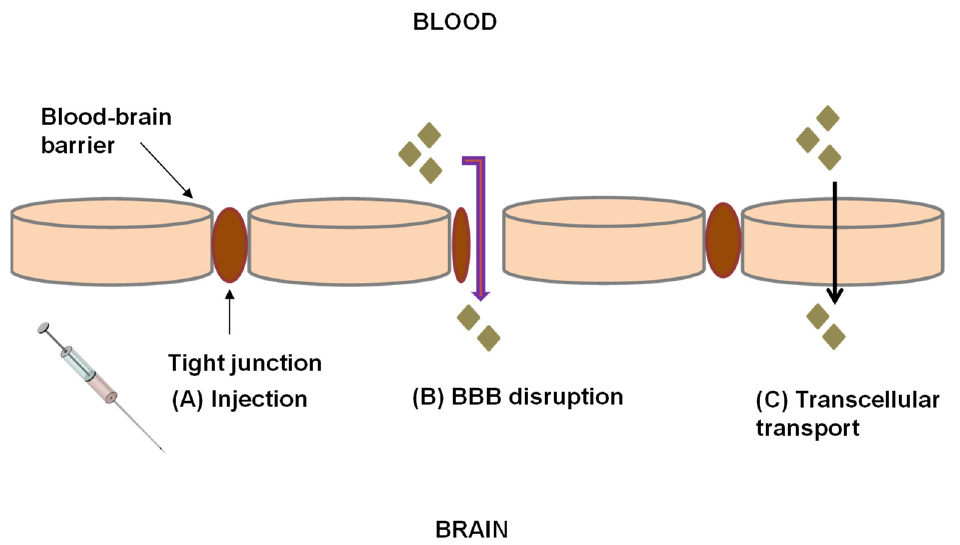
Figure 1. Strategies for crossing the BBB to deliver drugs. ( A ) Invasive approach: injection into the parenchyma of the brain is used to avoid the BBB when treating patients. ( B ) BBB disruption is achieved by injection of chemical agents, osmolytes or via focused ultrasound. This technique causes loosening of the tight junctions of the endothelium, permitting access to the brain by conventional drugs. ( C ) Transcellular transport of drug molecules through a cell.